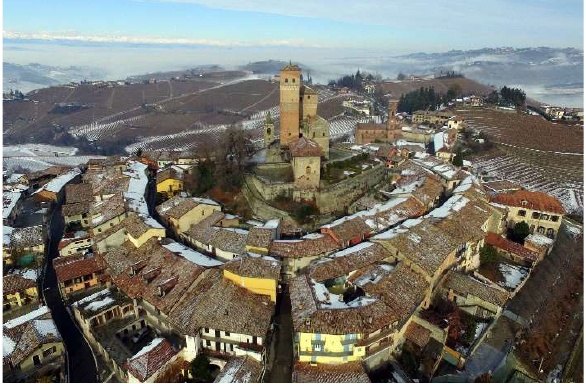
Figure 4. Serralunga d’Alba castle and his historical